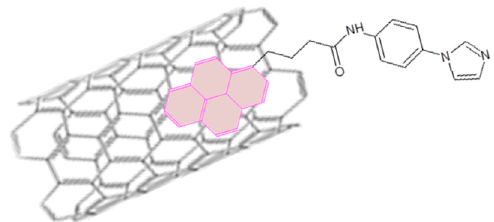
Figure 19. Interaction between CNT and pyrene functionalized with the imidazole entity according to the mechanism proposed in [113].